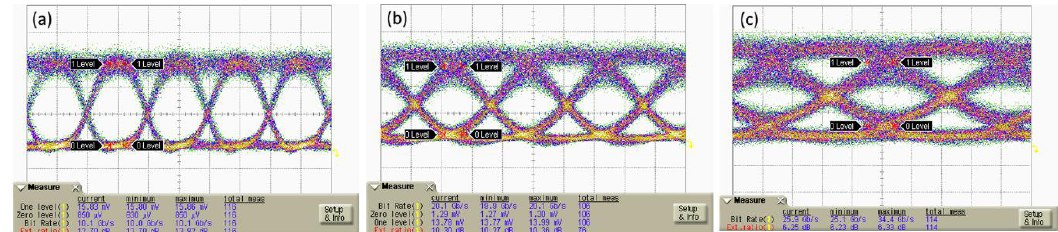
Figure 8. Eye diagram for MZI modulator at 1956.5 nm wavelength. ( a ) Data rate is 10 Gb/s and extinction ratio is 12.7 dB. ( b ) Data rate is 20 Gb/s and extinction ratio is 10.3 dB. ( c ) Data rate is 25 Gb/s and extinction ratio is 6.25 dB.